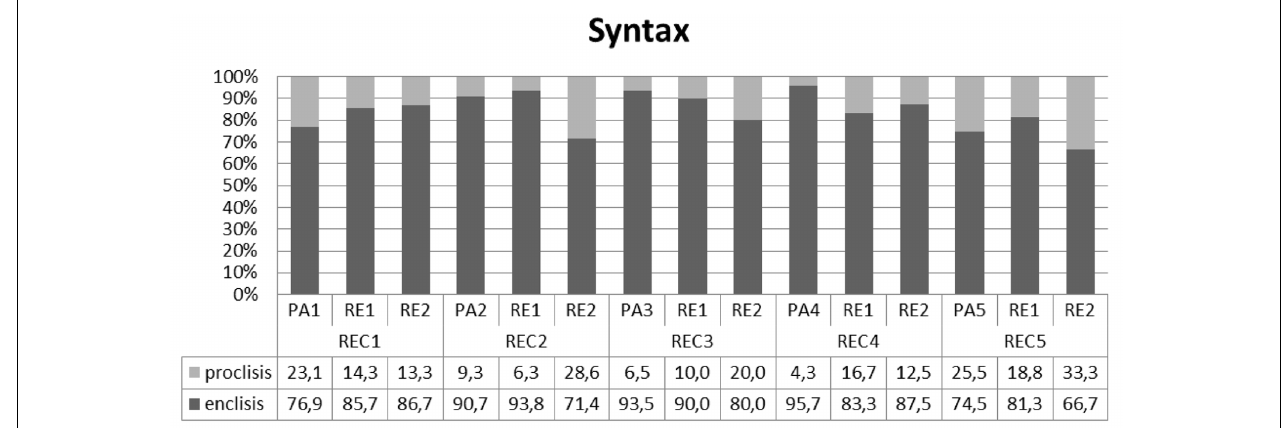
FIGURE 5 | Individual performance for each participant in syntax.